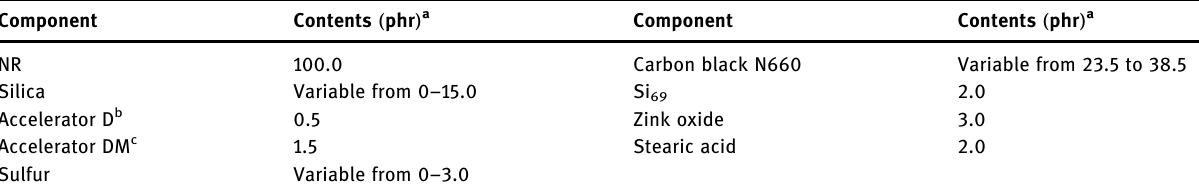
Table 1: Formulation of silica/NR composites